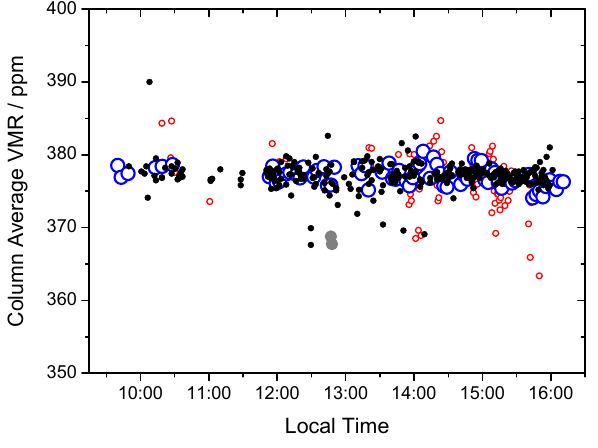
Fig. 7 Fig. 7. Time series of column average VMRs of CO 2 . OSA: large open circles; FTS: small open circles; FTS-GFIT: small solid cir- cles; GOSAT: gray solid circles. On 26 August 2009.